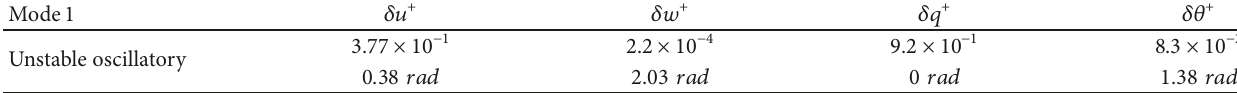
Table 4: Amplitude and phase in polar form of components of eigenvector of Mode 1 in Table